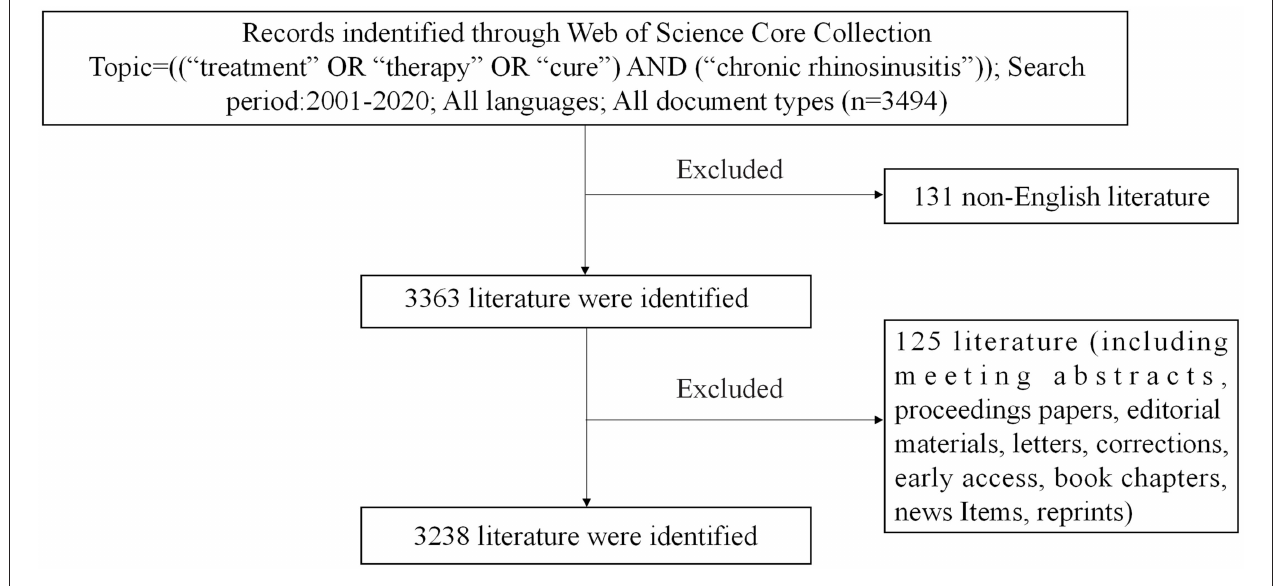
FIGURE 1 | Flowchart showing our search